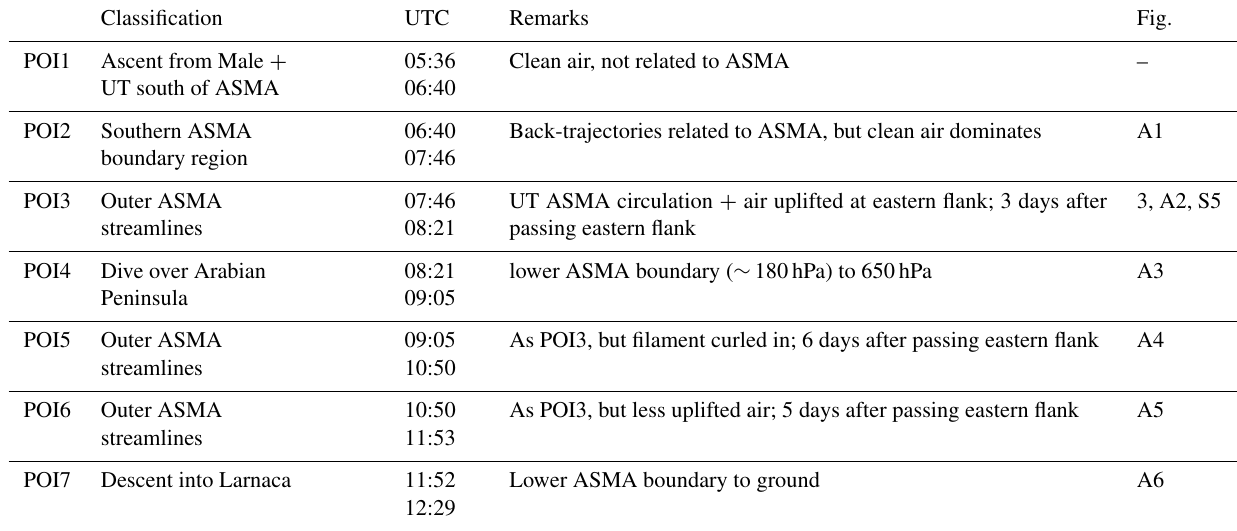
Figure 2. Mixing ratios of O 3 , HCl, NO y and CO, as simulated by EMAC for 06:00UTC on 18 September 2012, at 168hPa. Beads along the flight track are separated by 1h, and the tail end of the HALO silhouette marks the actual position. Black circles in panel (a) indicate the HALO position during the periods of interest, which represent the ASMA measurements. During POI3 HALO was flying in an altitude range containing the shown pressure level. Arrows illustrate the wind field (c) and also highlight a filament of TP layer entrainment into the free troposphere at the eastern ASMA flank, indicated by anti-correlated mixing ratios of HCl and CO ( b and d ). Table 1. Periods of interest for the measurements during the HALO ESMVal flight from Male to Larnaca on 18 September 2012. Column UTC shows the time periods of the measurements, figure lists the corresponding trajectory